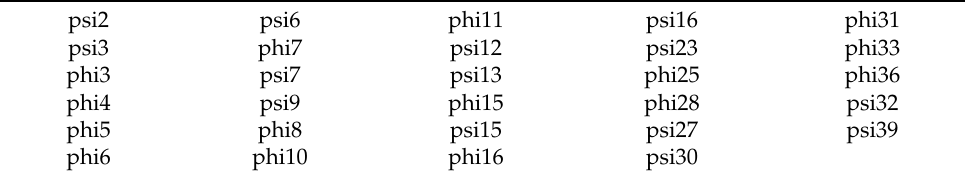
Table 2. List of Dihedral Angles Separating Disease Phenotype Based on Classification